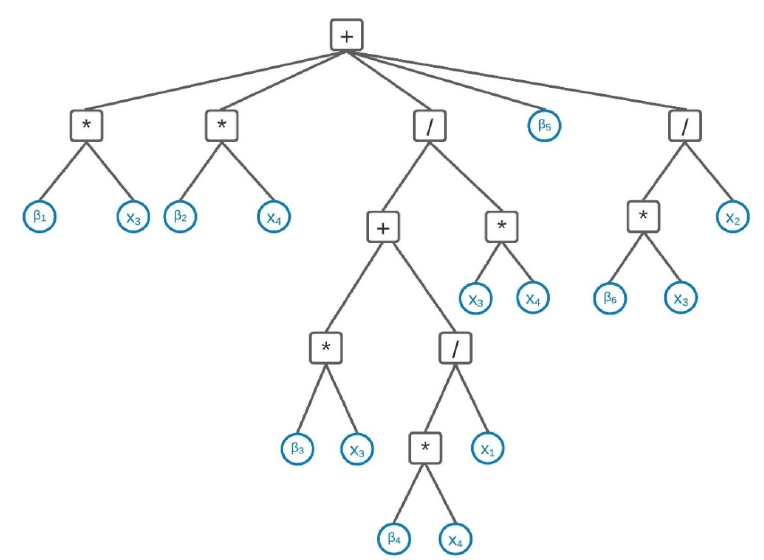
Figure 2. GP tree representing the selected metamodel.